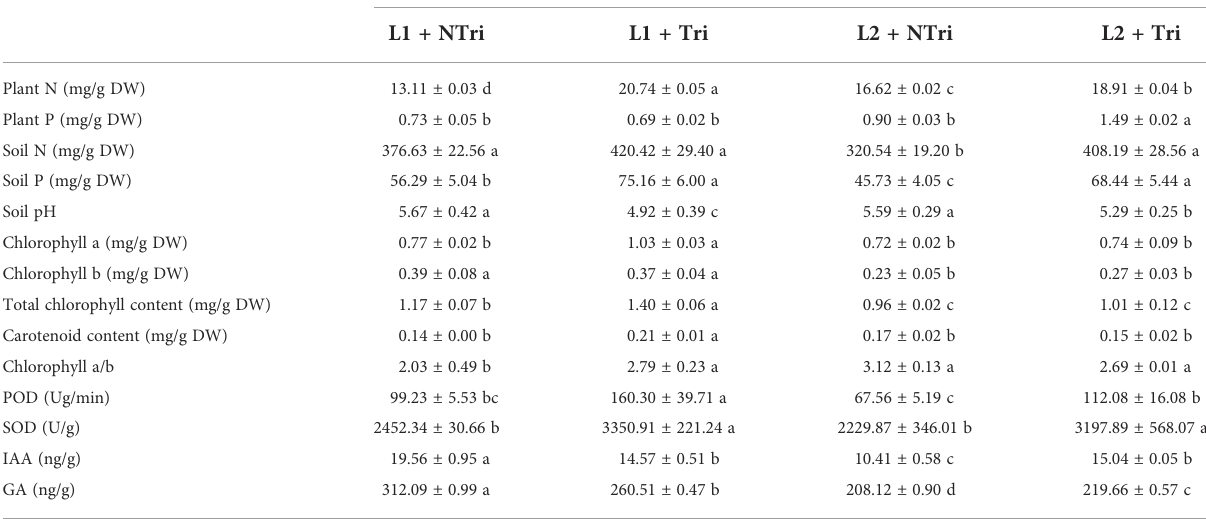
TABLE 1 Physicochemical indices of soil and N. benthamiana under the treatment combinations of the two light intensities and Trichoderma inoculation. Parameters